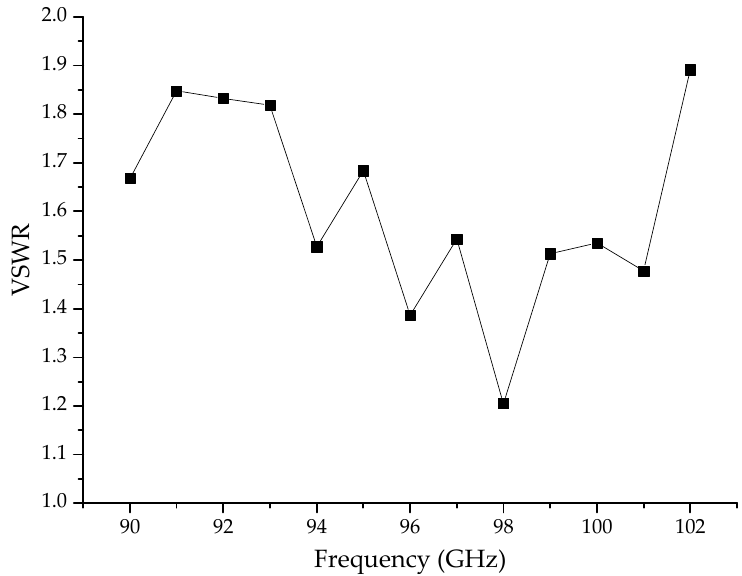
Figure 9. Calculated VSWR of the input coupler.